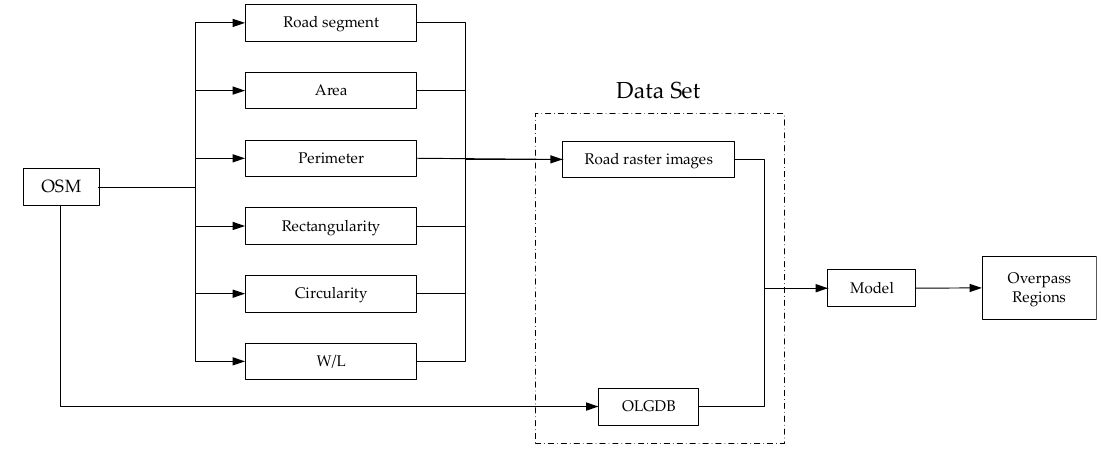
Figure 1 . Data flow chart . Figure 1. Data flow